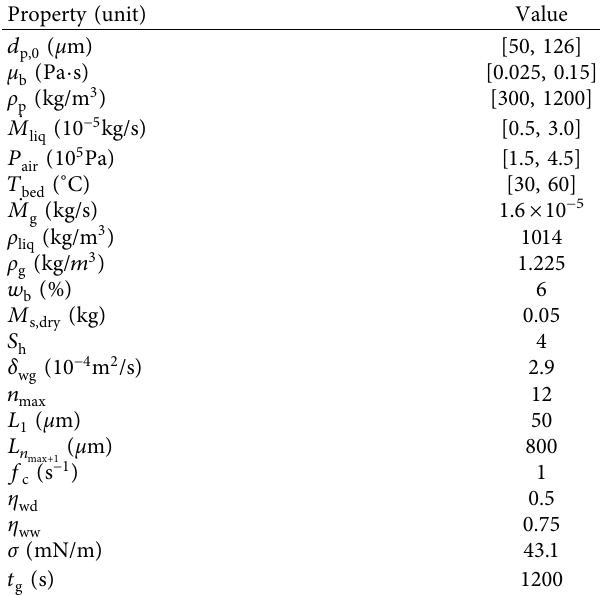
Table 1: The simulation experiment settings for